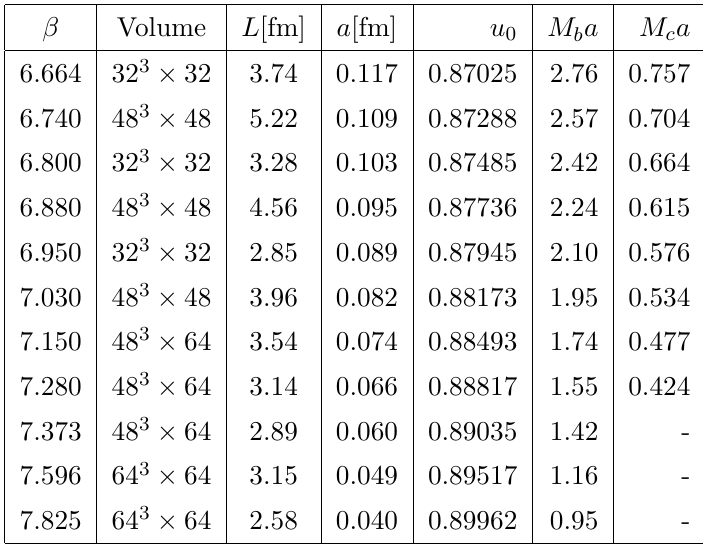
Table 1 . Parameters of the HISQ lattice con(cid:12)gurations at T = 0, which are used to calibrate the NRQCD energy shift and in cross-checks of the Bayesian reconstruction methods. For each lattice spacing there are 400 con(cid:12)gurations